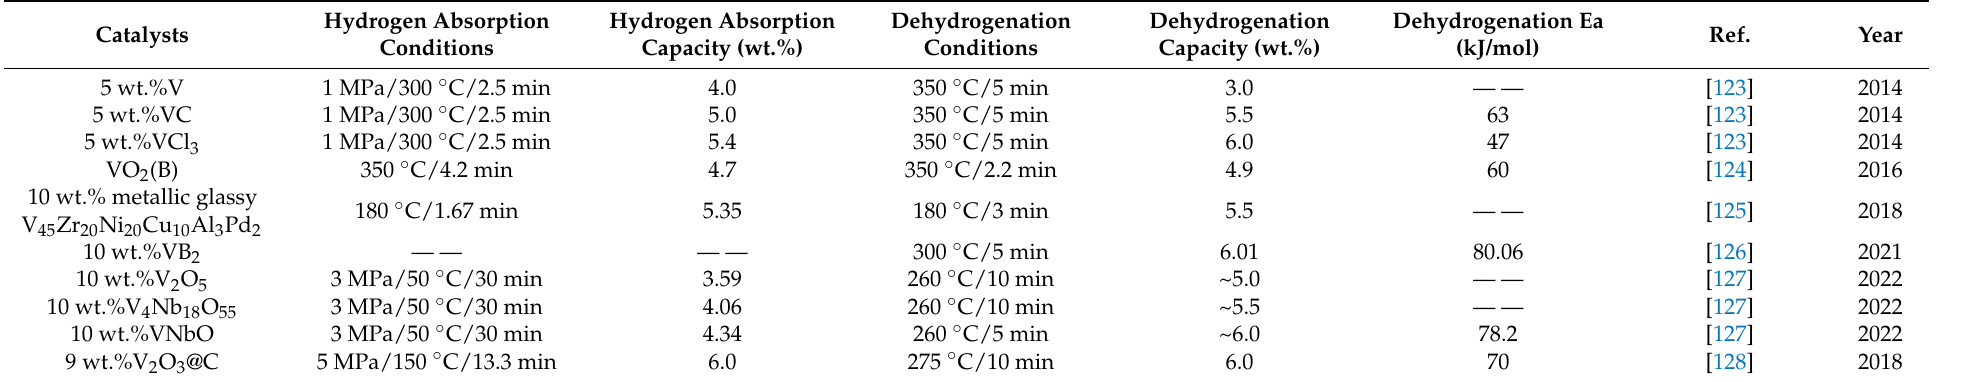
Table 6. Hydrogen storage performance of Mg/MgH 2 system doped with vanadium-based